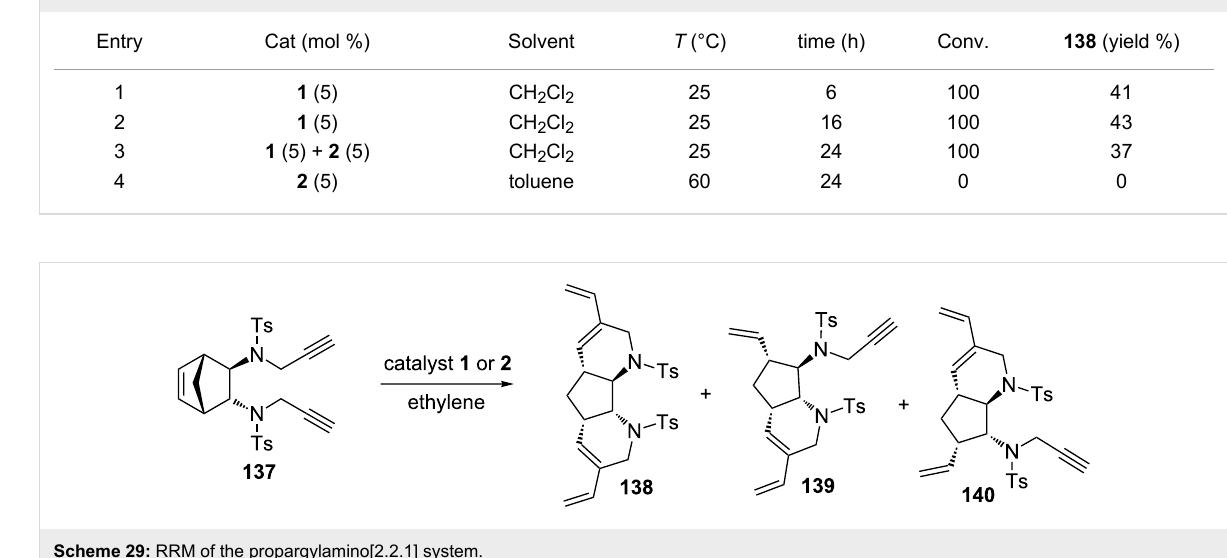
Table 1: RRM of propargylamino